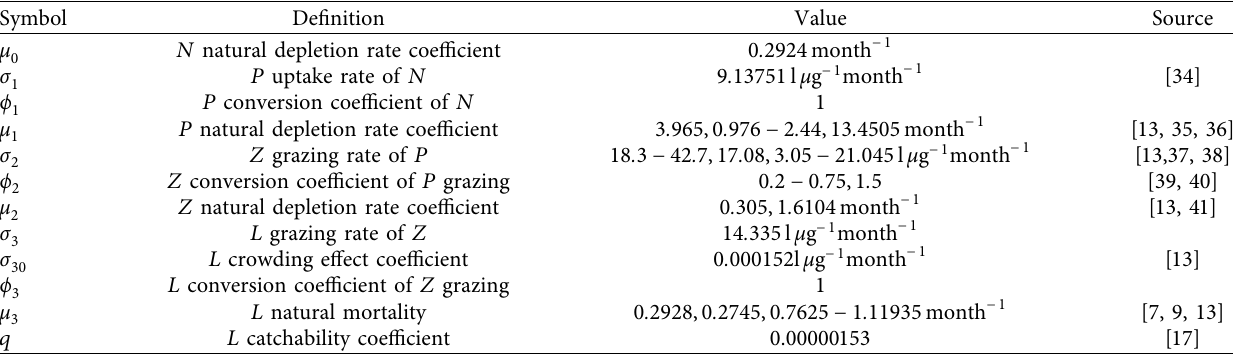
Table 2: Model parameters and their interpretations.